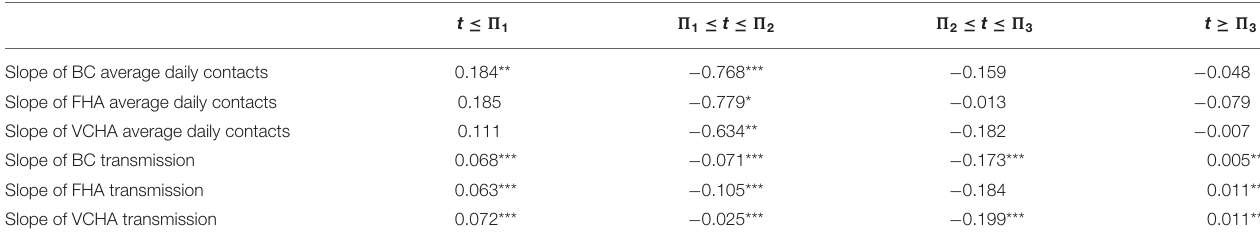
TABLE 1 | Slopes of regression lines of average daily contacts and transmission in the province and in FHA and VCHA, within the four time intervals separated by the three dates ( 5 1 , 5 2 and 5 3 ) of announcement of public health orders, based on associated model estimates β 1 , β 2 , β 3 and β 4 presented in Supplementary Tables S3, S5 in Appendix 4